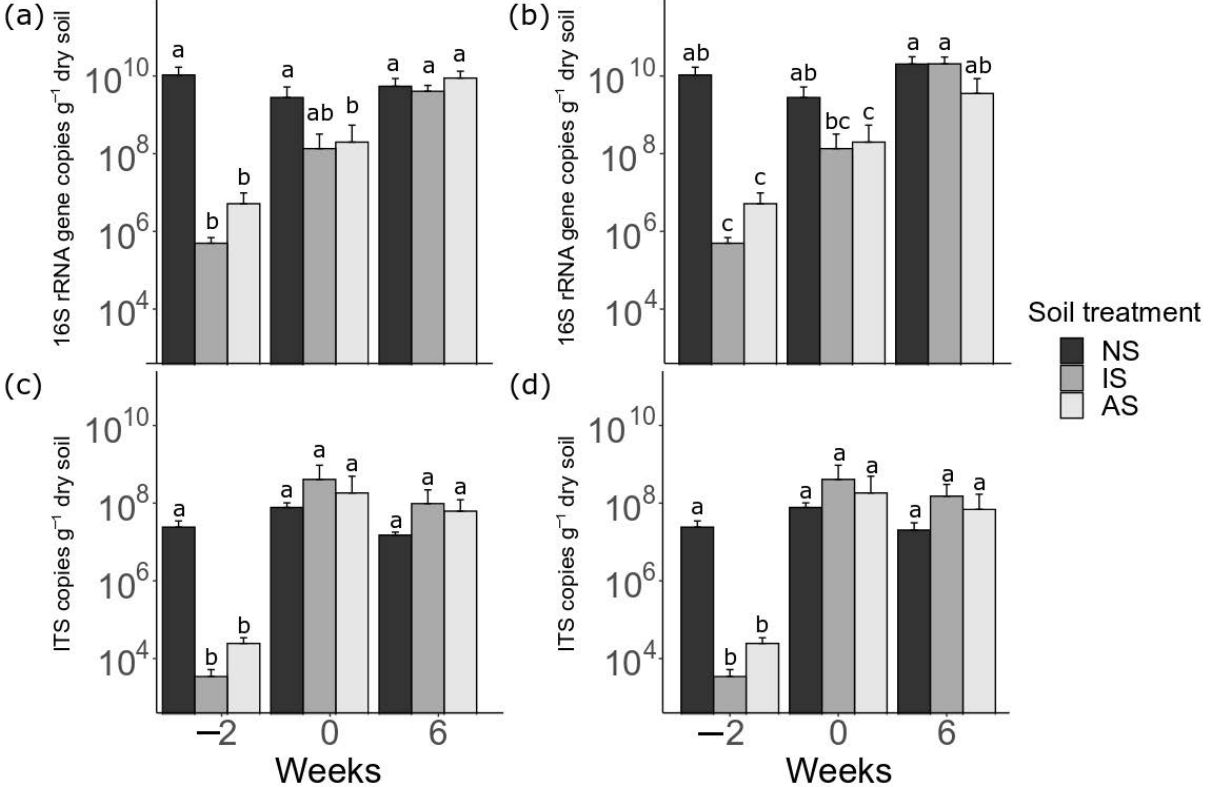
Figure 2. Copy numbers of the 16S rRNA gene and ITS regions representing bacterial and fungal abundance in soils (NS: natural soil, IS: inoculated soil, and AS: autoclaved soil) receiving natural ( a , c ) or autoclaved maize litter ( b , d ). Values represent the mean and the standard deviation of three replicates. Soils were incubated for 2 weeks (from week − 2 to 0) and then received litter materials (week 0). The final sampling took place after 6 weeks of litter incubation (week 6). Bacterial and fungal abundance were log-transformed before statistical tests to improve the normality of the data distribution. We performed a two-way ANOVA to investigate the interaction between time points and soil treatments on bacterial and fungal abundance, followed by Tukey’s HSD test for pairwise comparisons. Different letters indicate significant differences ( p < 0.05) according to Tukey’s HSD